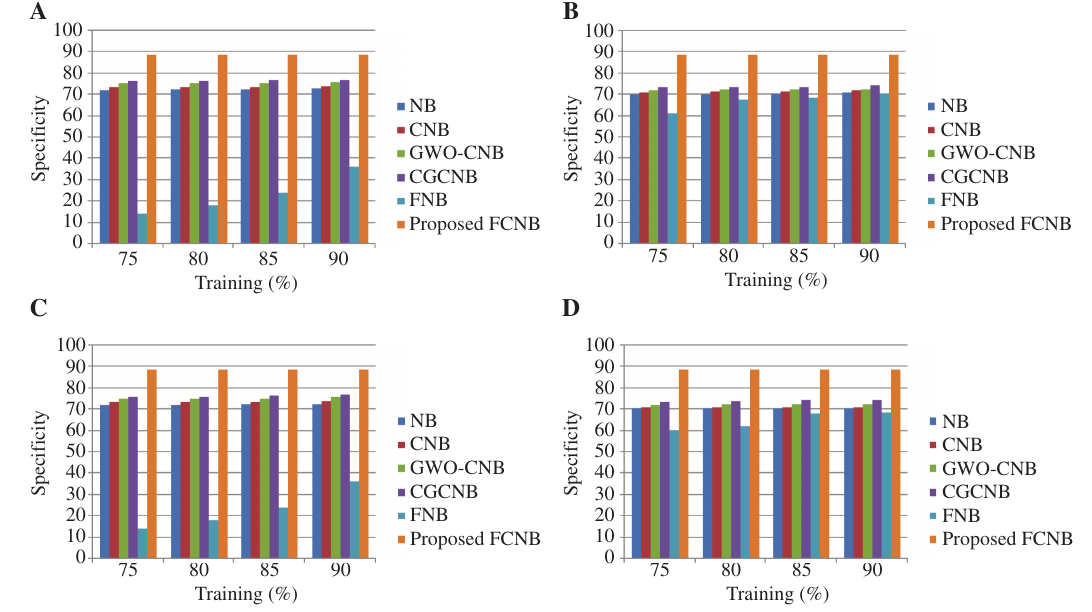
Figure 5: Comparative Analysis of the FCNB Classifier Based on Specificity. For mapper = 4 in (A) localization dataset and (B) skin dataset. For mapper = 5 in (C) localization dataset and (D) skin